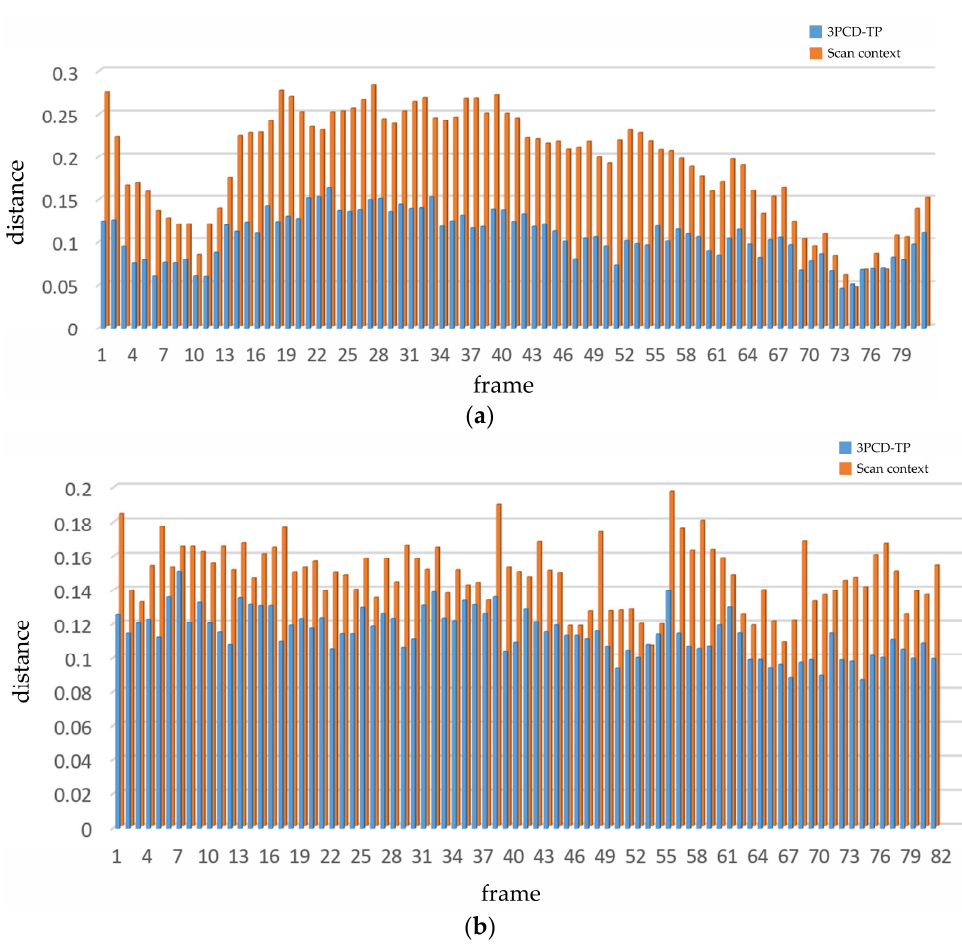
Figure 14. Histograms of the distance between the reverse loop frames of 3PCD-TP and SC. The x-axis represents the frame ID, and the y-axis represents the distance between current frame and the candidate that is the most similar to it. ( a ) Results for a section of the reverse lane in School-01; ( b ) results for a section of the reverse lane in School-03.